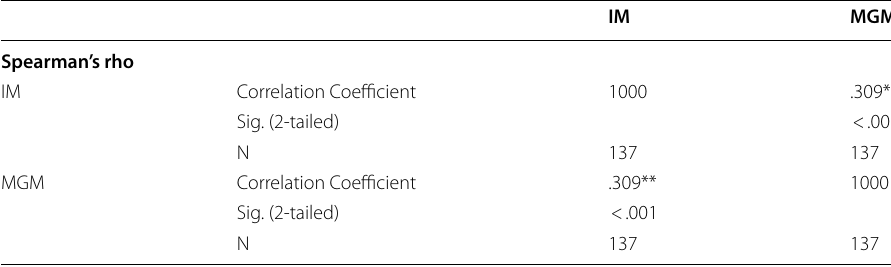
**Correlation is significant at the 0.01 level (2-tailed) Table 9 Correlation between IM and MGA